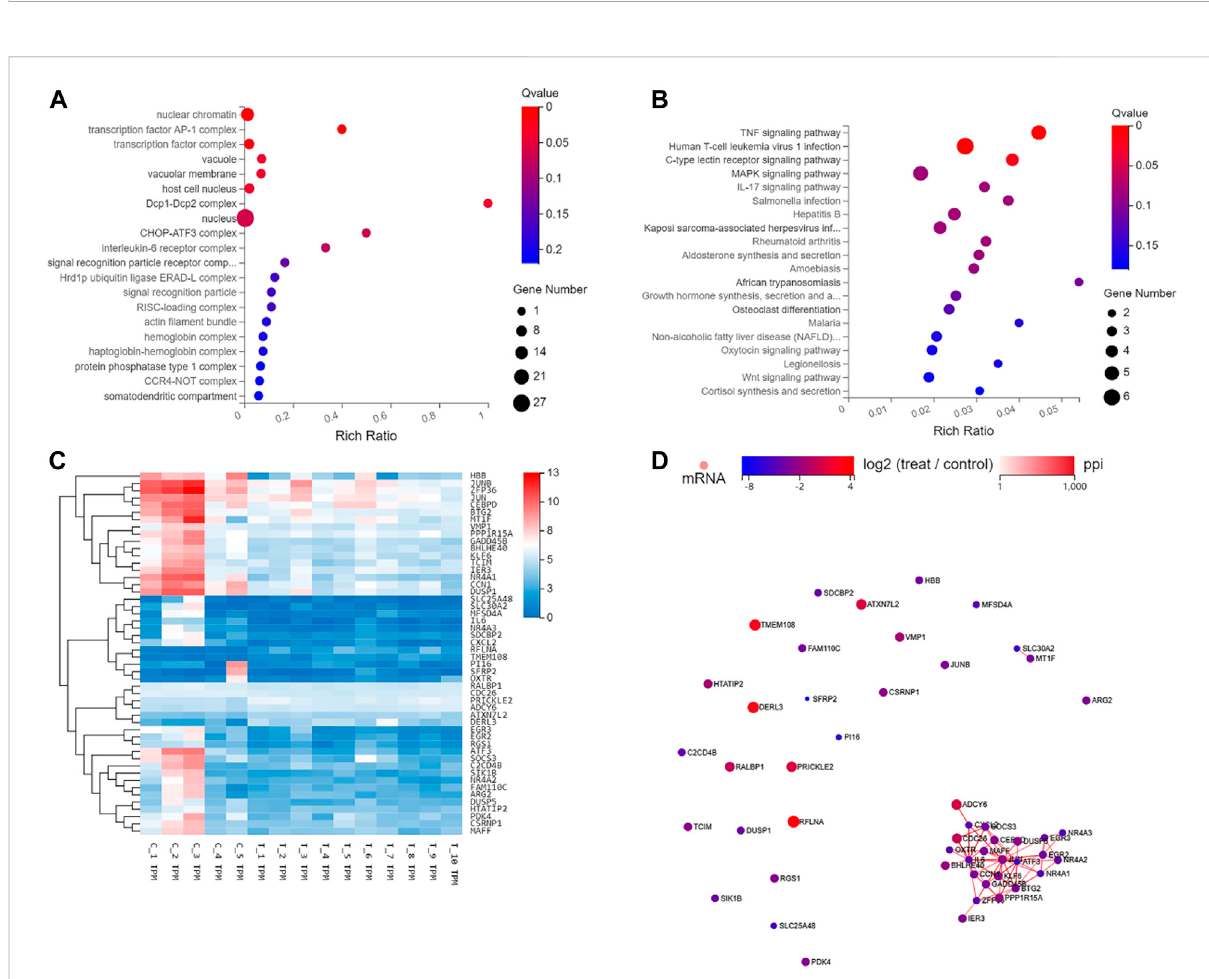
GO, KEGG, Hierarchical clustering, and gene regulatory network analysis of the 50 genes with the most signi fi cant differences. (A) GO function enrichment analyses of 50 differentially expressed genes between scar tissue with IUAs and myometrium with normal uterus. (B) KEGG pathway analysis ofthemost 50differentiallyexpressedgenesbetweenscartissue with IUAs and myometrium with normal uterus. (C) Hierarchical clustering analysis of genes with differential expression. (D) Differentially expressed miRNA-differentially expressed gene regulatory network. The red and green colors denote upregulation and downregulation,